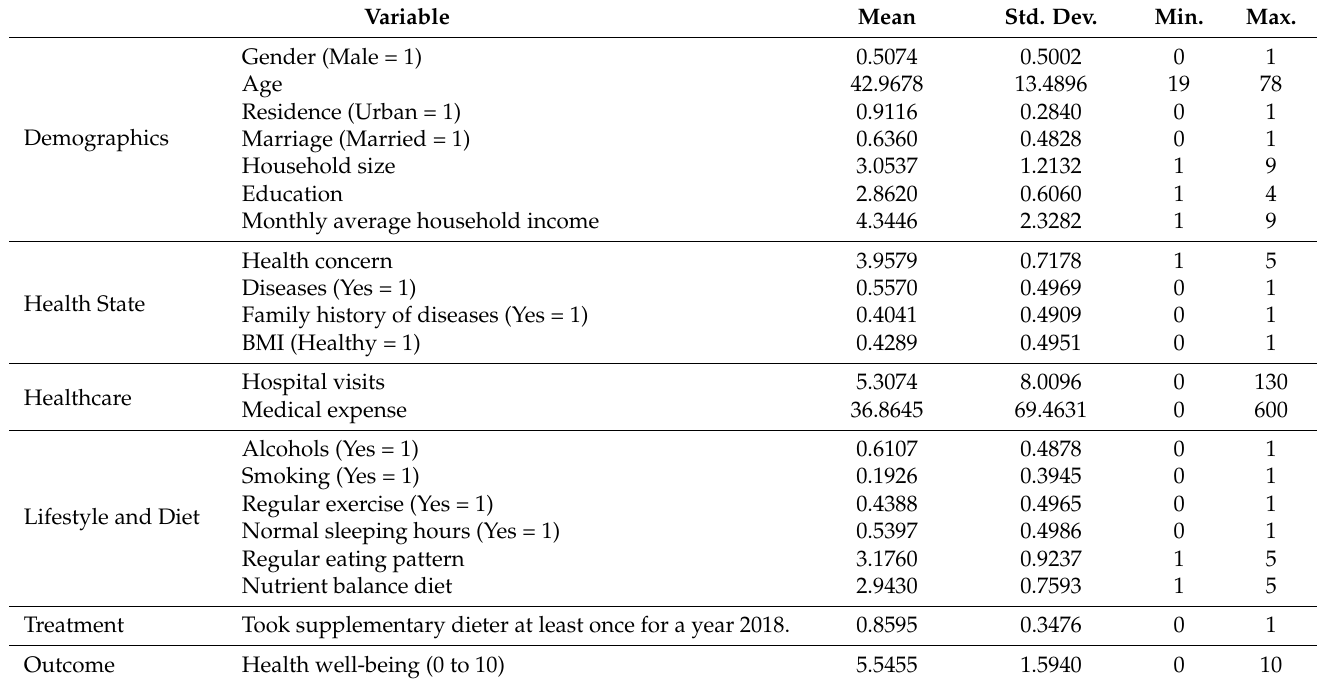
Table 2. Descriptive statistics ( N = 1210).